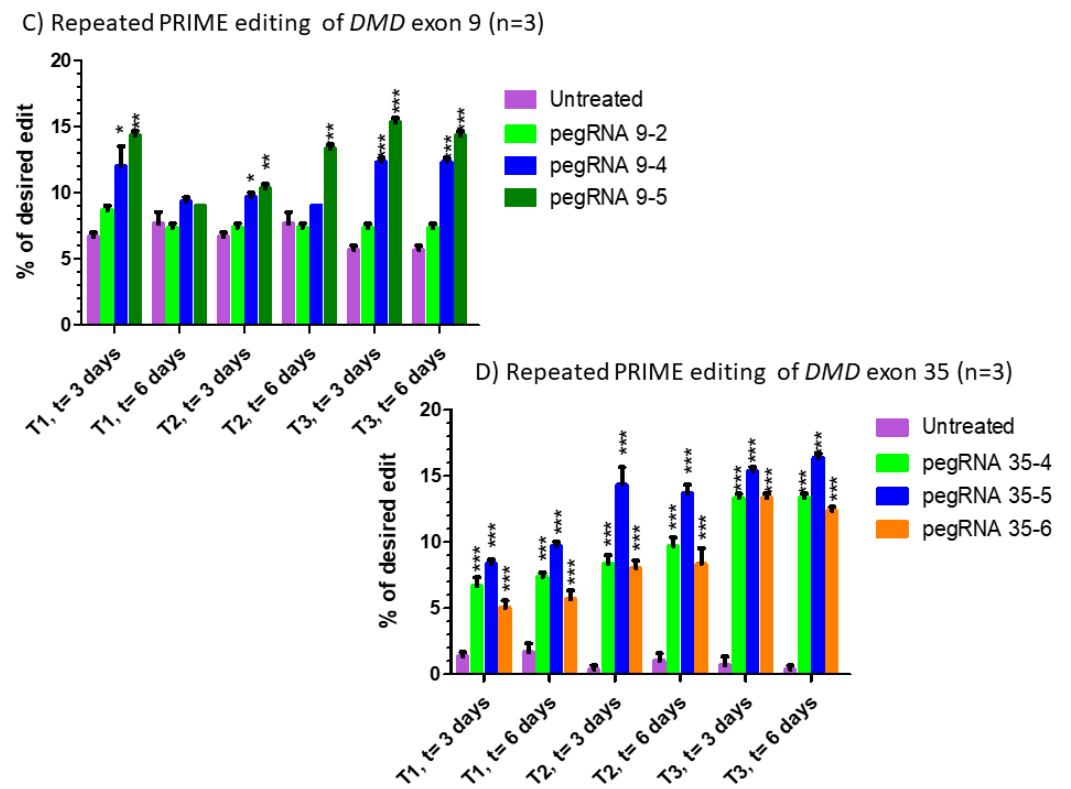
Figure 4. Repeated prime editing ( A ) Scheme summarizing the timing of the three successive prime editing treatments. The experiment was done in triplicate. HEK293T cells were transfected three times (at days 0, 7 and 14) with the plasmids pCMV-PE2 and pU6-pegRNA-GG-acceptor. The pegRNAs were targeting either the EMX1 gene ( B ), exon 9 of the DMD gene ( C ) or exon 35 of the DMD gene ( D ). DNA was extracted from cell samples at 3 and 6 days after each treatment (i.e., at days 3, 6, 10, 13, 17 and 20). The percentages of desired nucleotide mutations were determined by Sanger sequencing and analysis with EditR. The figures illustrate the average and standard deviations. These percentages increased with the second treatment for the EMX1 gene and DMD exon 35. The third treatment with pegRNA35-5 and pegRNA35-6 increased the mutation of DMD exon 35. The results were analyzed by an analysis of variance. The *, ** and *** indicate, respectively, a level of significance with a p value less than 0.001, 0.0001 and 0.00001 relative to the untreated cells (negative control). These experiments were carried out in independent triplicates ( n = 3).